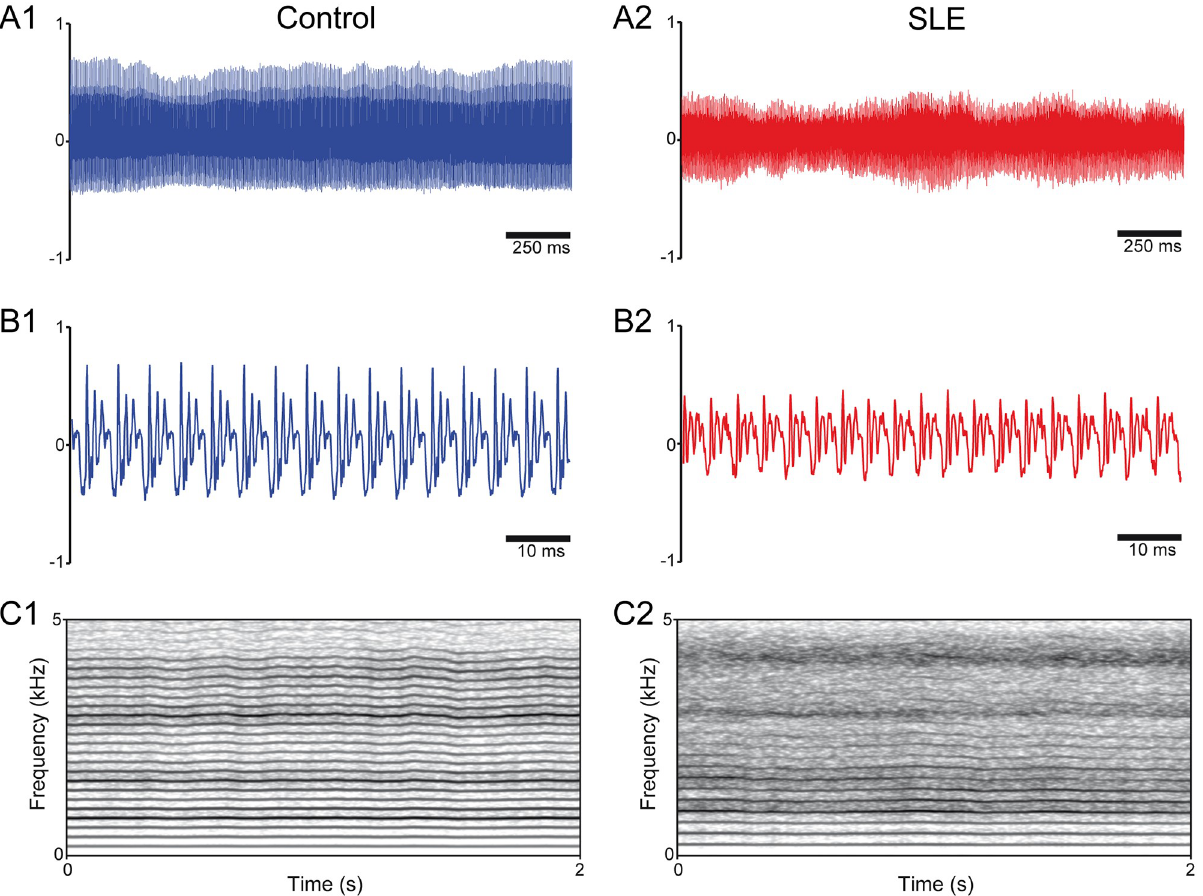
Fig 1. Representative voice recordings and spectrograms of SLE patients and healthy controls. A: Sound recordingsof /a/ vowel phonationsfrom a control subject (A1) and a patient with SLE (A2); note the high variabilityof the signal from the SLE patient in relationto the control. B: Zoomed in views of the recordingspresentedin A1 and A2; there is a noticeablereduction in the amplituderange in the SLE patient voical signal in relationto the representative control recording. C: Spectrogram (frequencydomain) representations of the recordings presentedin A1 and A2; note the high level of background noise and low formant segregationin the SLE patient compared to the healthy control.